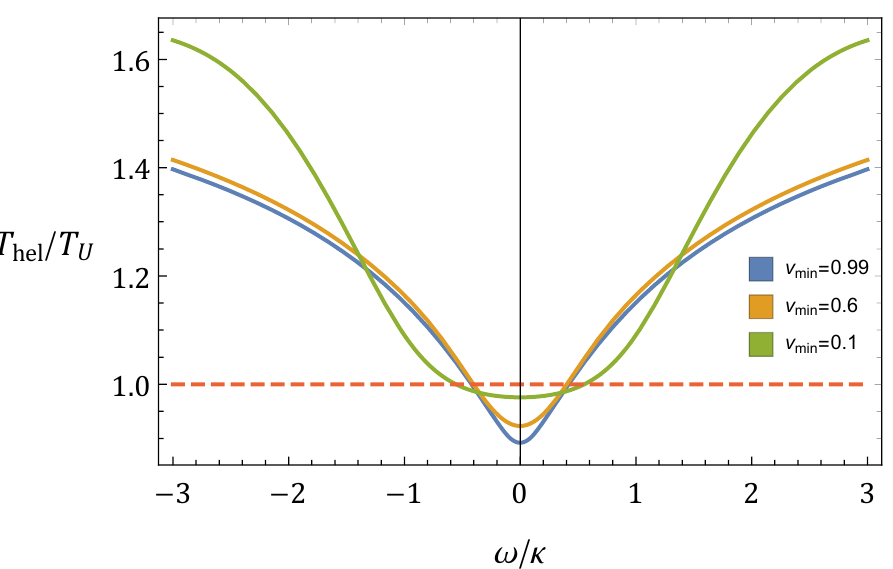
Figure 8 . E(cid:11)ective temperature along the Hypertor (helix) worldline for (cid:20) = b = 1 and the speed varies as a function of hypertorsion obeying eq. (3.20). Near the speed of light, for v min = 0 : 99, (cid:23) (cid:25) 0 : 010. For v min = 0 : 6, (cid:23) (cid:25) 0 : 516 and for v min = 0 : 6, (cid:23) (cid:25) 2 : 846 . The Unruh temperature, T U , is indicated by a red dashed